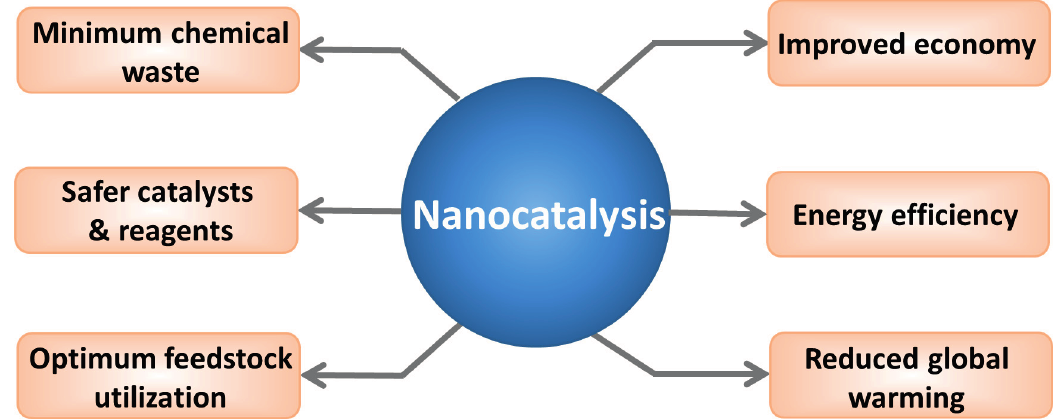
Figure 1. The expected benefits of nanocatalysis. Reprinted from [2] with permission from Wiley-VCH Verlag GmbH & Co. KGaA, Copyright